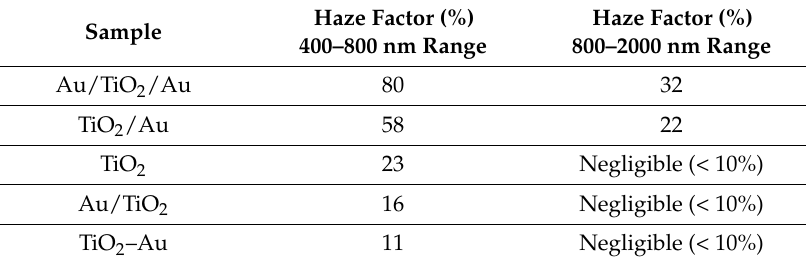
Table 2. Haze factor % of the samples in two wavelengths.